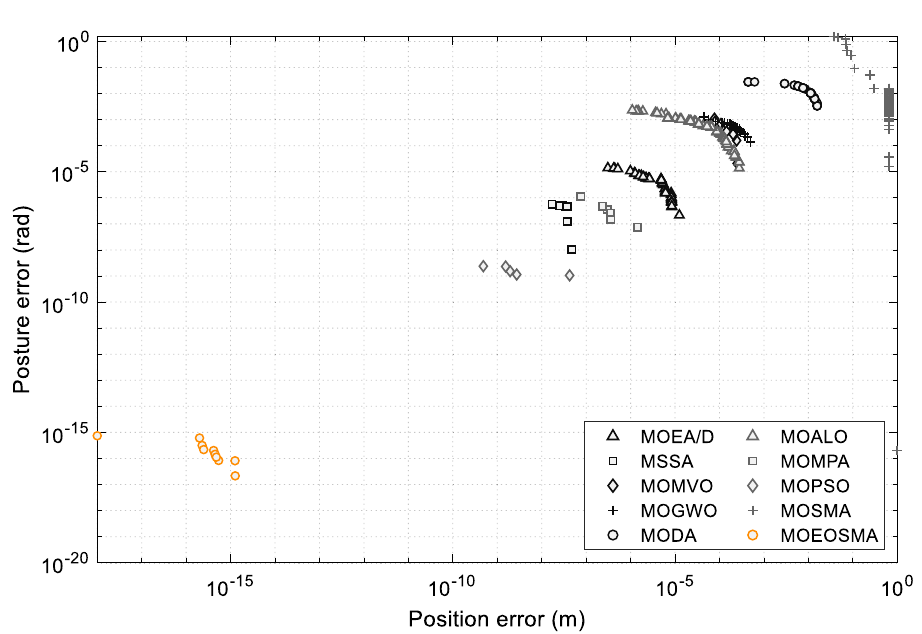
Figure 18. The PF obtained by multi-objective algorithms at desired pose P 2